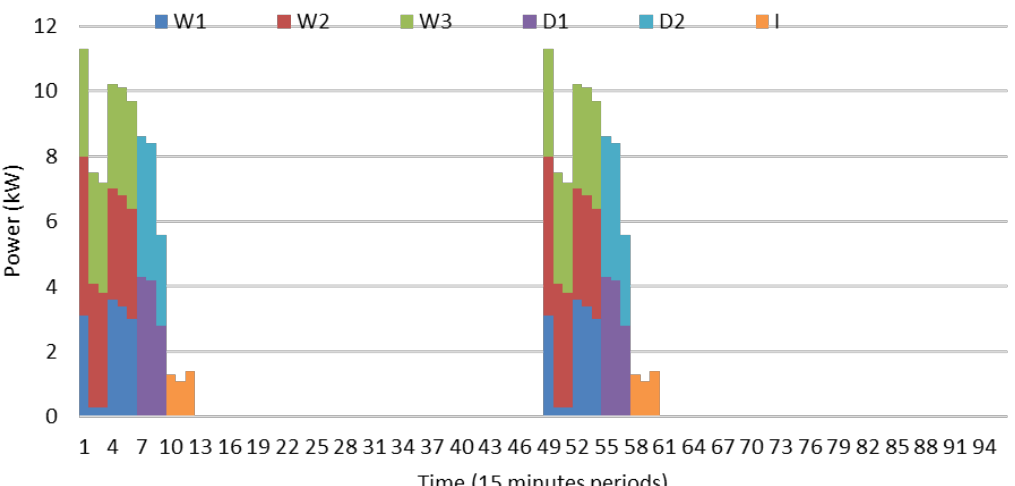
Figure 2. Power consumption of devices before optimization.